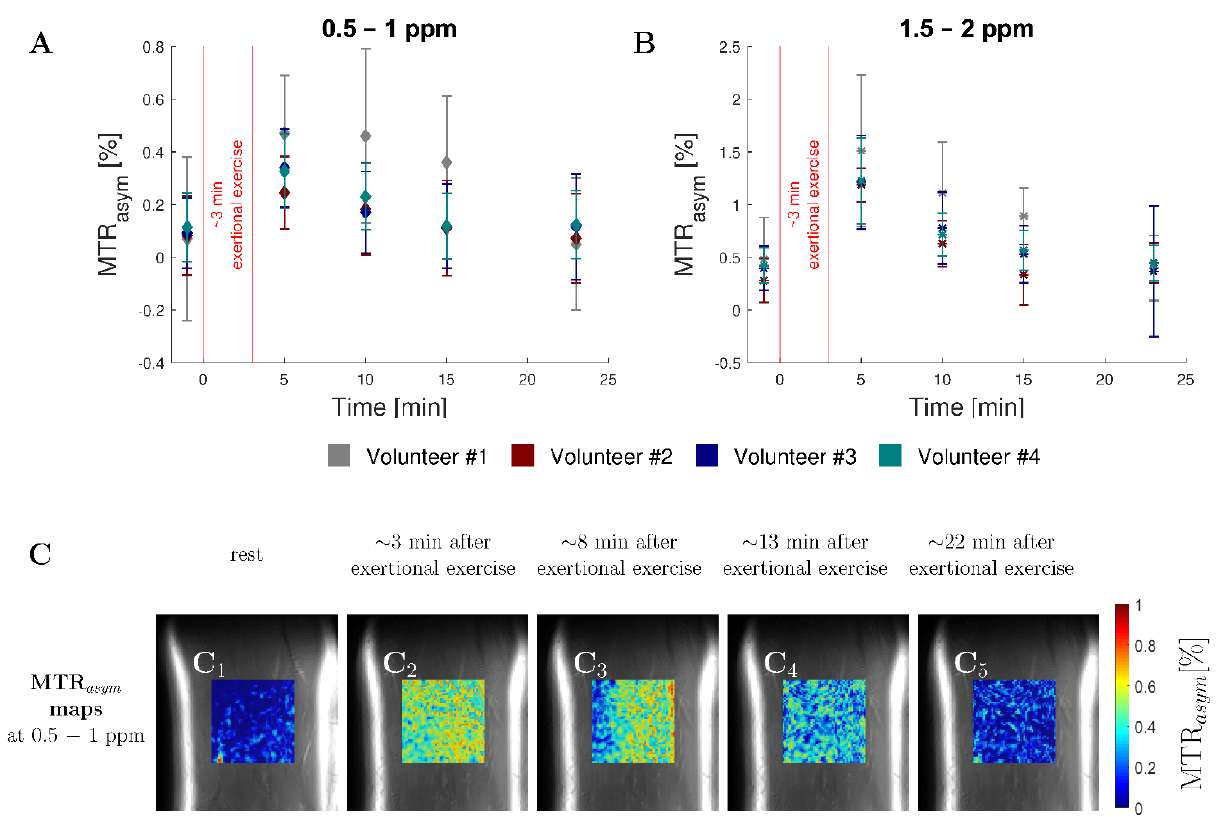
Figure 5. Longitudinal changes of MTR asym values (given as mean and standard deviation) of the four human calves before and immediately after exertional exercise. ( A ) Immediately after exercise, we observed in all volunteers (different colors) a substantial increase in MTR asym values in the lactate-specific range of 0.5 – 1 ppm. During the following post-exercise period, this increase gradually equilibrated to reach the resting state. ( B ) Similarly, in the creatine-specific range of 1.5 – 2 ppm, we observed a corresponding increase and decrease in MTR asym values following exertional exercise. ( C ) Morphologic images of a representative human calf overlaid with the MTR asym maps in the range 0.5 – 1 ppm with successive time points indicated by C 1 to C 5 .